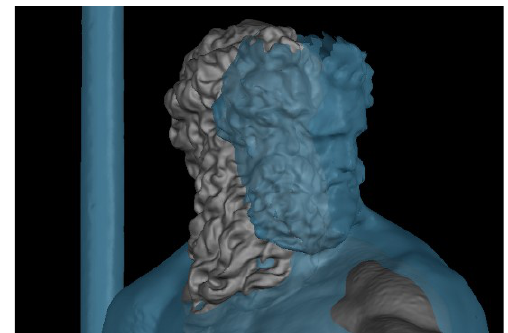
Figure 11. Detail of the head in the two